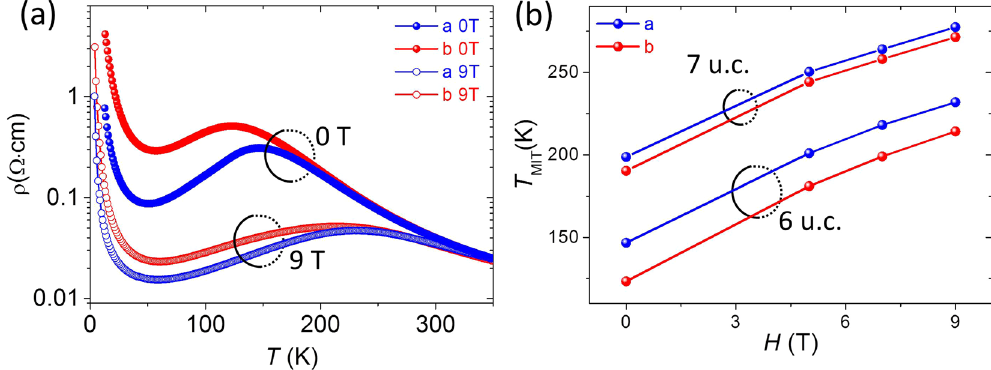
Figure 4. ( a ) Resistivity of 6 uc LSMO along a and b -axes as a function of temperature with and without 9 T magnetic field. ( b ) Magnetic field dependent T MIT for 6 and 7 uc LSMO films. The magnetic field was along out of plane